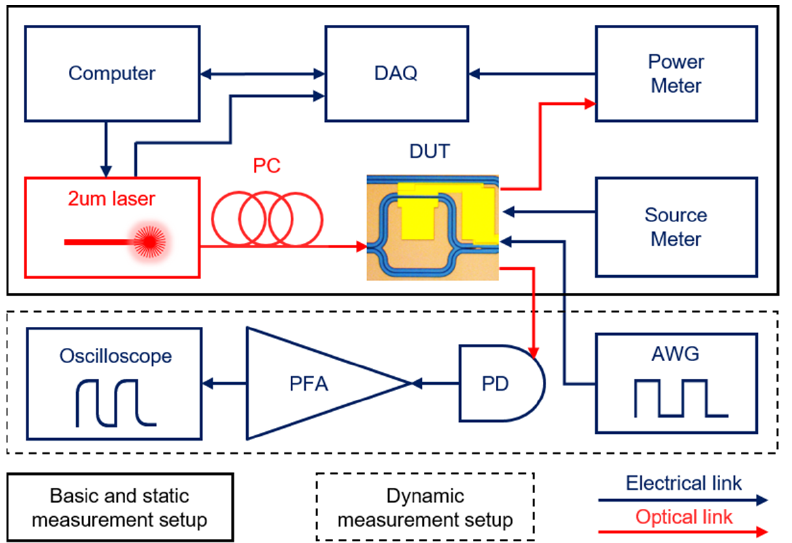
Figure 2. Schematic of the measurement setup. DAQ: data acquisition equipment, PC: polarization controller, DUT: device under test, AWG: arbitrary waveform generator, PD: photodetector, PFA: pulse forming amplifier (based on photomultiplier tube).